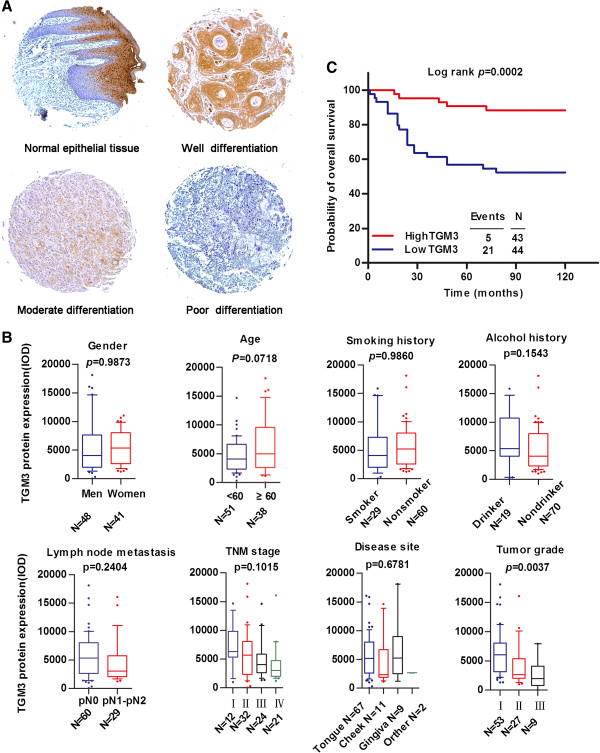
Correlation between TGM3 expression and clinicopathological parameters and clinical outcome in patients with HNSCCs. (A) Representative images show immunohistochemical staining for TGM3 expression in normal epithelial tissue, well differentiated HNSCC, moderately differentiated HNSCC and poorly differentiated HNSCC. (B) The associations between TGM3 expression and clinicopathological factors were investigated in patients with HNSCCs (Twelve patients were excluded due to the samples shedding in the process of antigen retrieval and due to an insufficient number of tumor cells in the sections). (C) Kaplan-Meier survival curves illustrate the overall survival of patients with HNSCC relative to TGM3 expression (Two patients were excluded from survival analysis because of missing follow-up data).